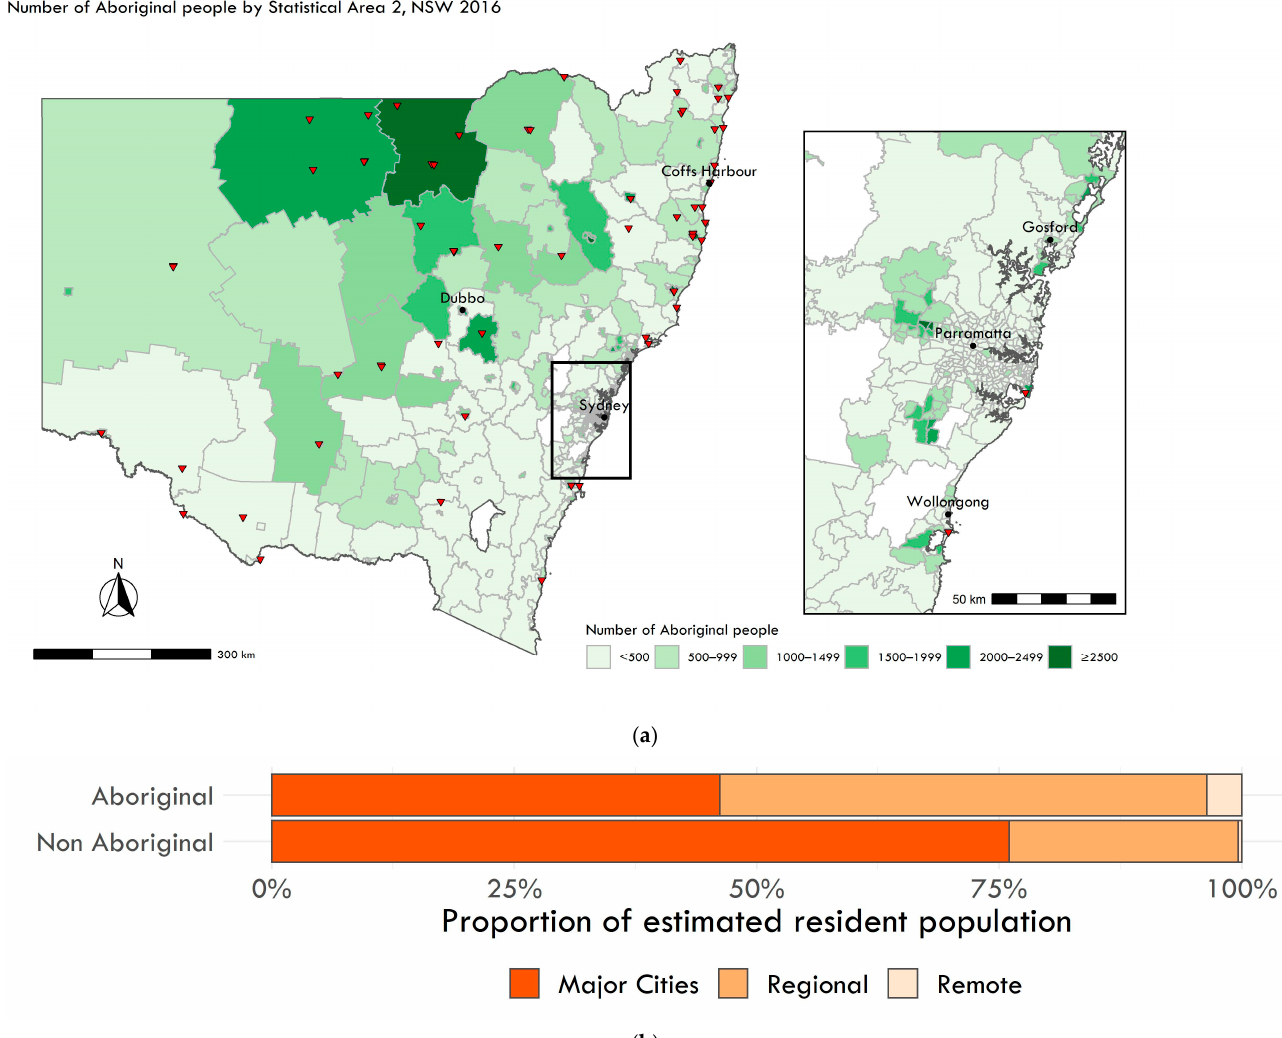
Figure 1. Distribution of Aboriginal people in NSW, 2016: ( a ) Number of Aboriginal people by Statistical Area 2 in NSW and the Greater Sydney Regions, 2016. Triangle markers indicate discrete Aboriginal communities with populations between 10–1000 people. ( b ) Proportion of Aboriginal versus non-Aboriginal populations by rurality. Source: Australian Bureau of Statistics [22] and NSW Ministry of Health, Environmental Health Branch.